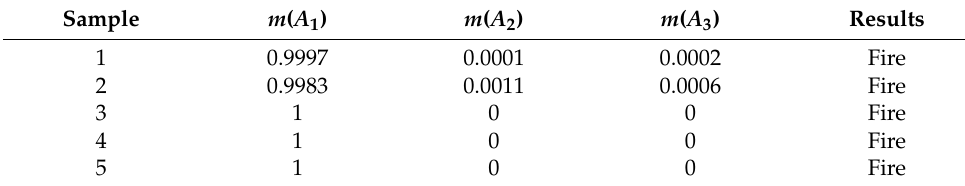
Table 7. The results of the D-S evidence theory fusion